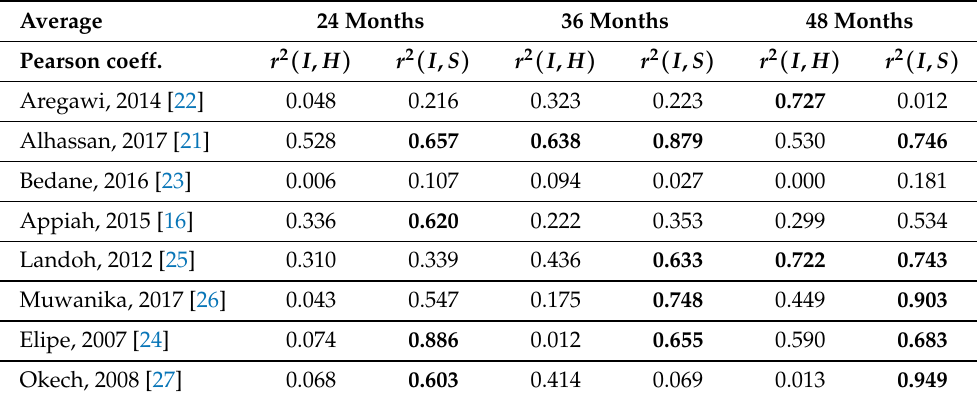
Table 3. Pearson correlation coefficient r 2 , between pairs among the three metrics malaria incidence I , the Hurst exponent H and Shannon entropy S . The three metrics were computed for three different time-windows of 24, 36 and 48 months. See also Appendix B. Results with r 2 > 0.600 are highlighted in bold. Average 24 Months 36 Months 48 Months Pearson